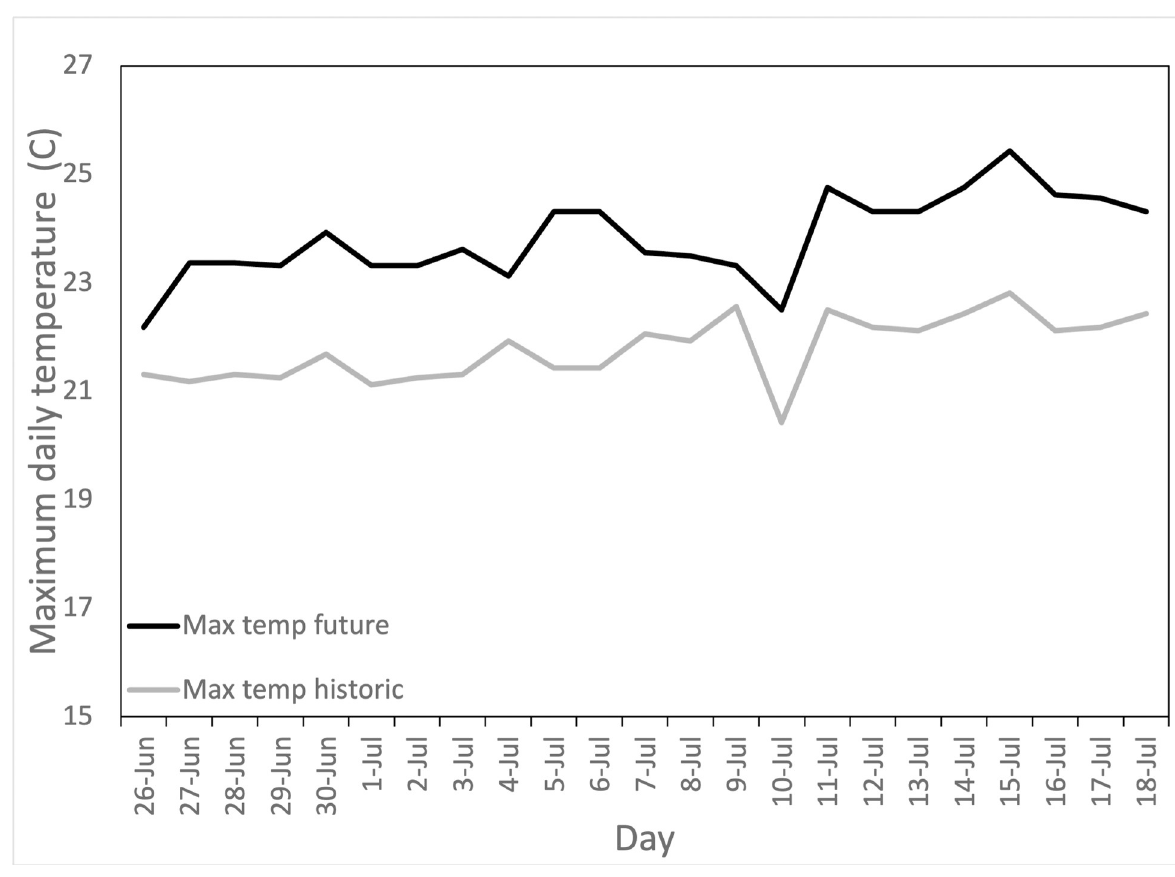
Fig 2. Representative daily measured maximum temperature in a historic treatment tank and a future treatment tank. Daily maximum measured temperatures did not always reach the daily set temperature due to power issues with heaters (see [42]), but a consistent difference between the treatment groups was maintained. Temperature scenarios were designed to provide variation in daily maximum temperature, while maintaining an overall positive slope to represent the increase in average daily temperature over the summer months.